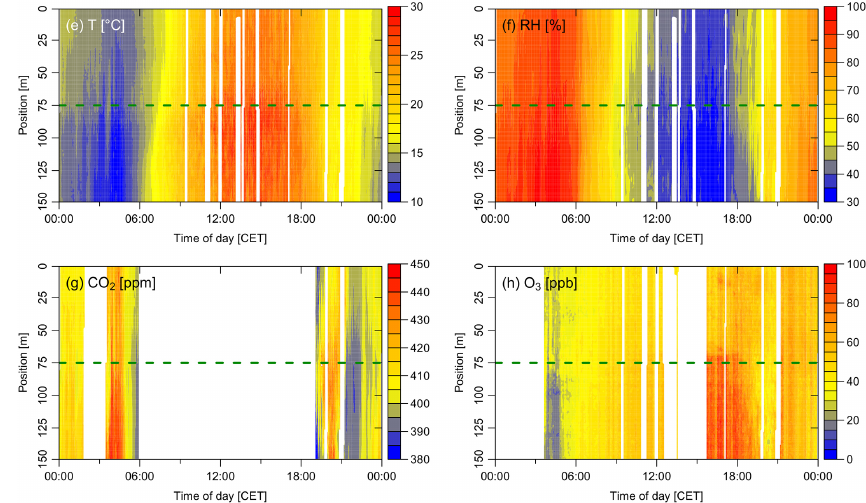
Figure 6. (Continued) Complete horizontal profile for the whole of 28 June 2011 for all measured quantities. (e) shows the temperature ( T ) and (f) the relative humidity (RH). (g) shows the carbon dioxide concentration (CO 2 ) and (h) the ozone concentration (O 3 ). Position shows distance from the starting point in metres, with starting point in the forest (0m), forest edge (75m, horizontal green dotted line) and endpoint at the clearing